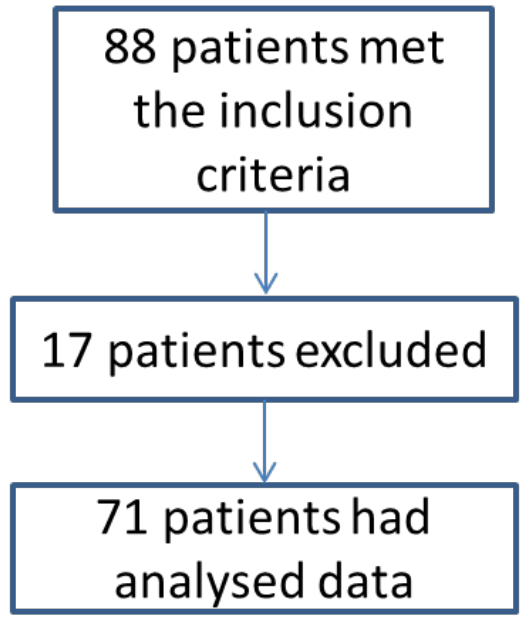
Figure 1. Flowchart study.